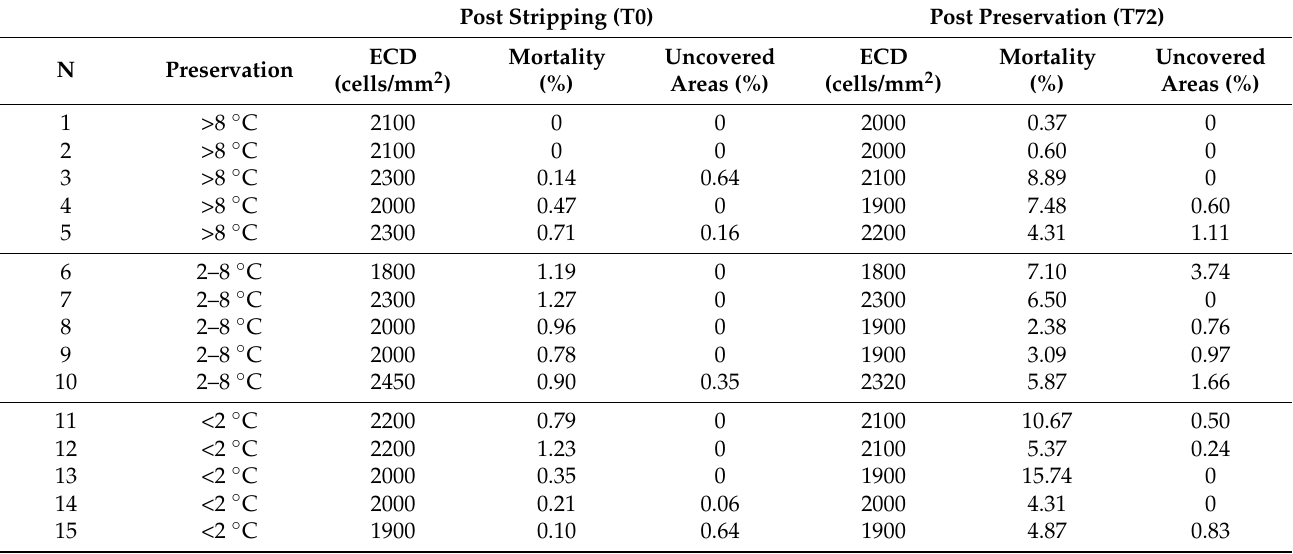
Table 1. Post-stripping and post-preservation endothelial cell density, mortality rate and uncovered areas in Group A (storing for 72 h post-stripping in Optisol-GS at >8 ◦ C), Group B (2–8 ◦ C) and Group C (<2 ◦